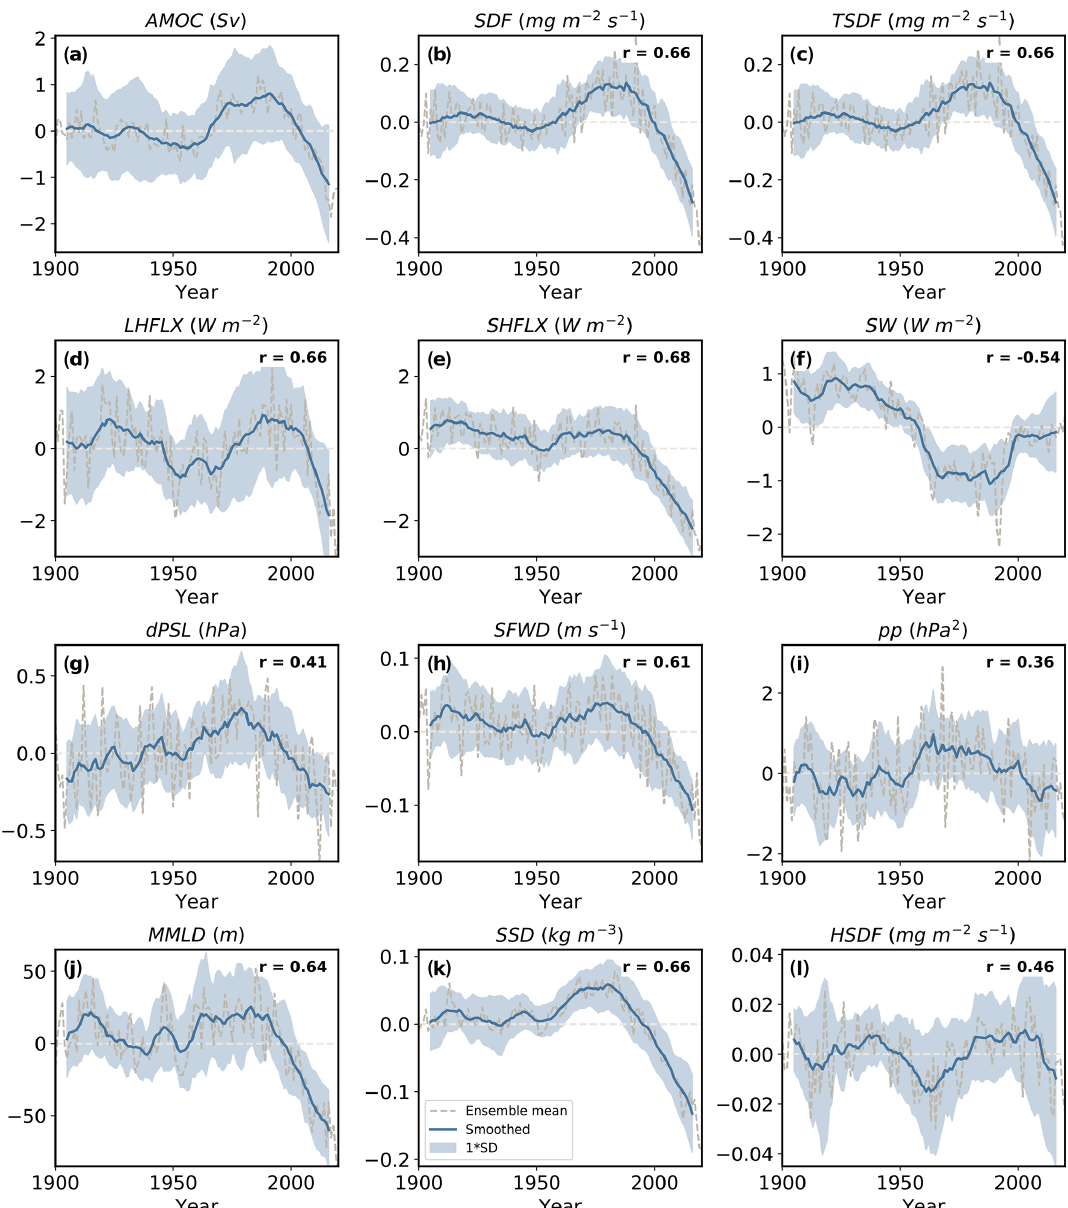
Figure 1. The 1900–2020 ensemble mean annual mean all forcing Coupled Model Intercomparison Project phase 6 normalized time series: (a) Atlantic meridional overturning circulation (AMOC) and subpolar North Atlantic (b) surface density flux (SDF), (c) thermal SDF (TSDF), (d) latent heat flux (LHFLX), (e) sensible heat flux (SHFLX), (f) net downward surface shortwave radiation (SW), (g) sea level pressure gradient (dPSL), (h) surface wind (SFWD), (i) storm track activity (pp), (j) March mixed-layer depth (MMLD), (k) sea surface